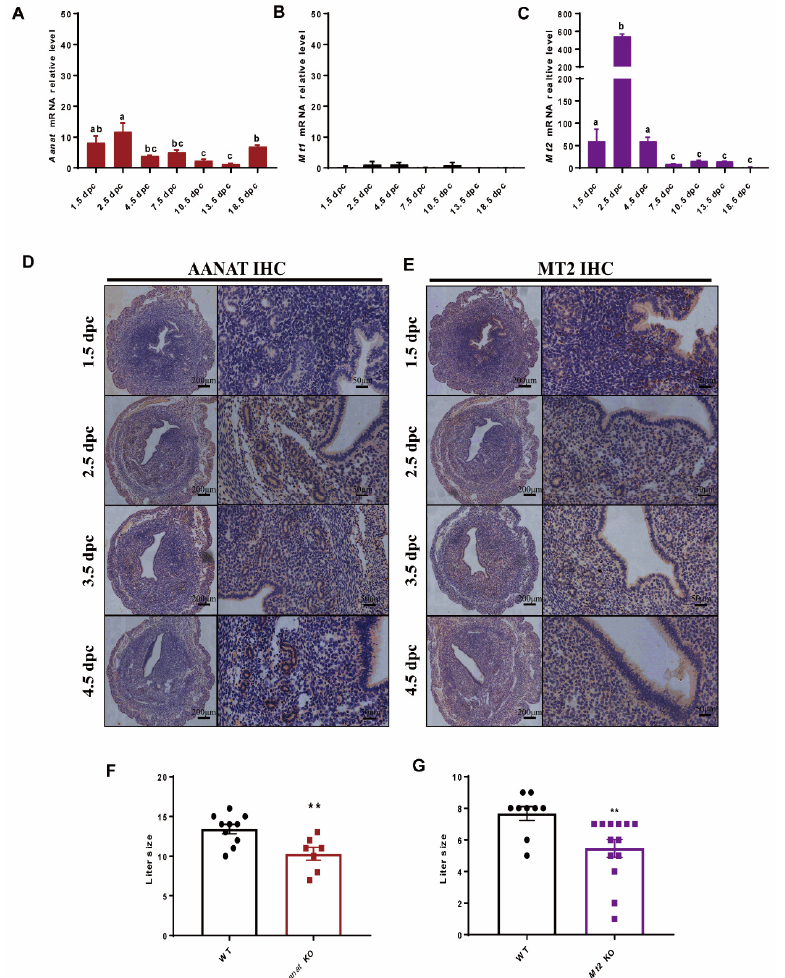
Figure 1. The expression patterns of Aanat and Mt1/2 in the uterus and their KO for mice fertility. ( A – C ) Aanat , Mt1 , and Mt2 expression during pregnancy in mouse uteri. Values with superscript letters a,b,c are significantly different across columns ( p < 0.05) ( D ) AANAT immunohistochemistry (IHC) at 1.5 dpc, 2.5 dpc, 3.5 dpc, and 4.5 dpc. ( E ) MT2 immunohistochemistry at 1.5 dpc, 2.5 dpc, 3.5 dpc, and 4.5 dpc. ( F , G ) Fertility assessment in the control (n = 10) and Aanat KO mice (n = 8); control (n = 9) and Mt2 KO mice (n = 13); * p < 0.05, ** p < 0.01. To further explore the potential molecular mechanisms of uterus-generated melato- nin on the physiology of endometrium during pregnancy, the Aanat and the Mt2 KO mice were reconstructed via the CRISPR/Cas9 system. The F3 generation homozygotes of the KO mice were used in this study. The results showed that the average litter size ( Aanat KO, 10.29 ± 0.81 vs. WT, 13.4 ± 0.6, Figure 1G; M t2 KO, 5.462 ± 0.56 vs. WT, 7.7 ± 0.441, Figure 1H) was signi fi cantly reduced in the KO mice compared with the WT ones ( p < 0.05). 2.2. E ff ects of Aanat KO on Embryo Implantation and Uterine E2 and P4 as Well as Their Related Downstream Gene Responses at 4.5 dpc In order to determine the exact time period of embryo loss, the uteri were taken from pregnant mice at di ff erent timepoints. The results showed that on day 4.5 of pregnancy,